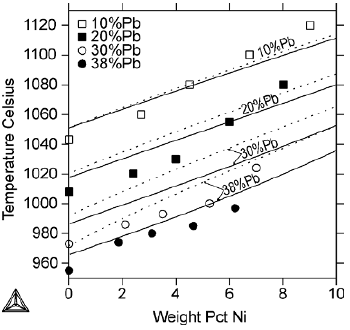
Figure 5. Calculated liquidus temperatures of Cu-Ni-Pb alloys Figure 6. Calculated isopleth of the Cu-Ni-Pb system at 60 wt% Pb, at low nickel contents, together with experimental data together with experimental data points [14,15]. Solid lines points [15]. Solid lines refer to the calculations of this refer to the calculations of this study and dashed lines study and dashed lines refer to those of [24]. refer to those of [24].